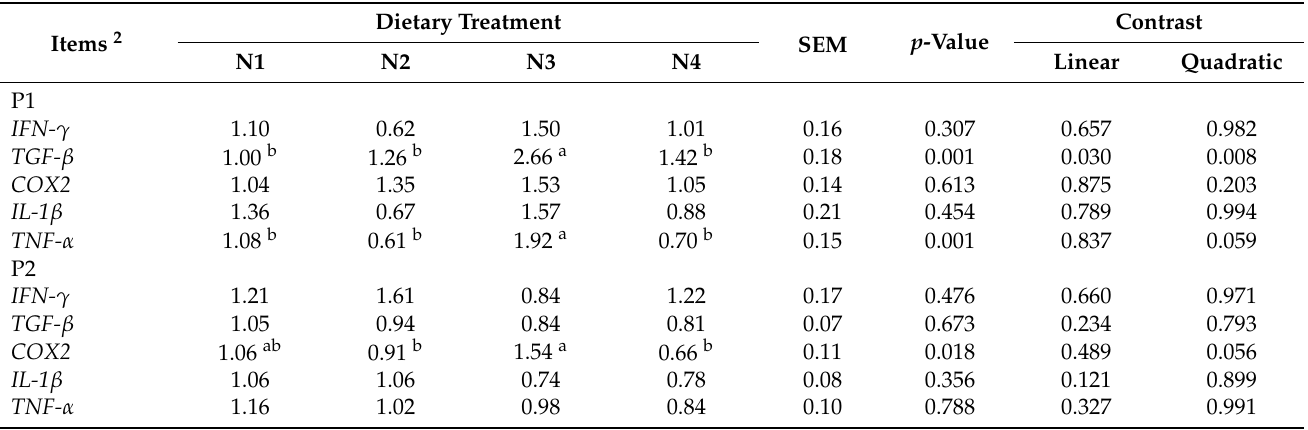
Table 5. The mRNA expression of inflammatory cytokines in jejunal mucosa of weaned piglets with different niacin concentrations 1